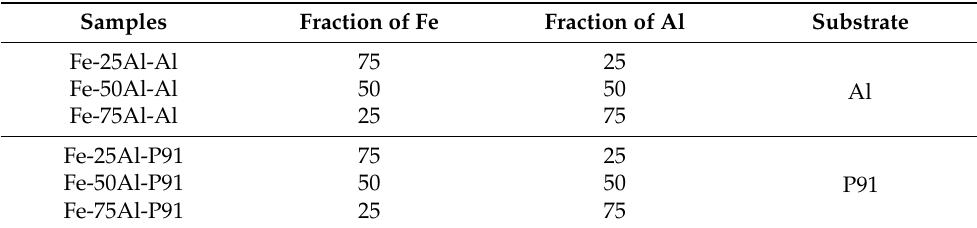
Table 1. Constituents of samples (wt.%).